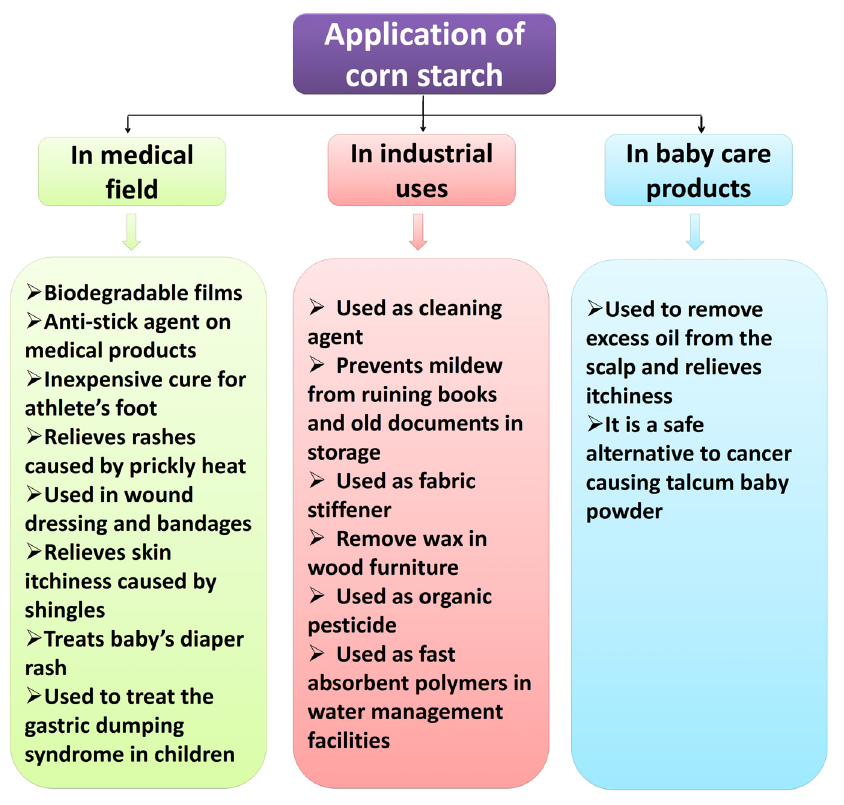
Figure 3. Di ff erent applications of corn Figure 3. Different applications of corn starch.